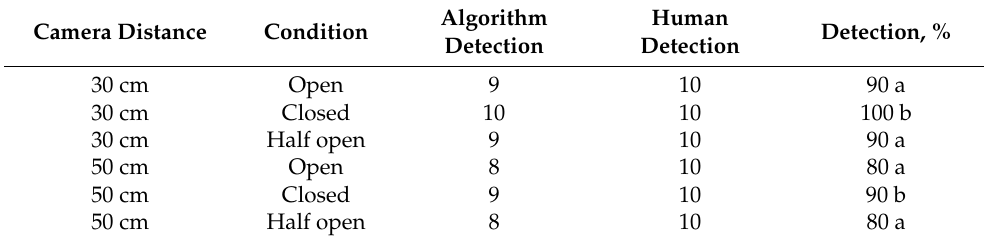
Table 3. DL performance to detect bagworms at different camera distances and areas.